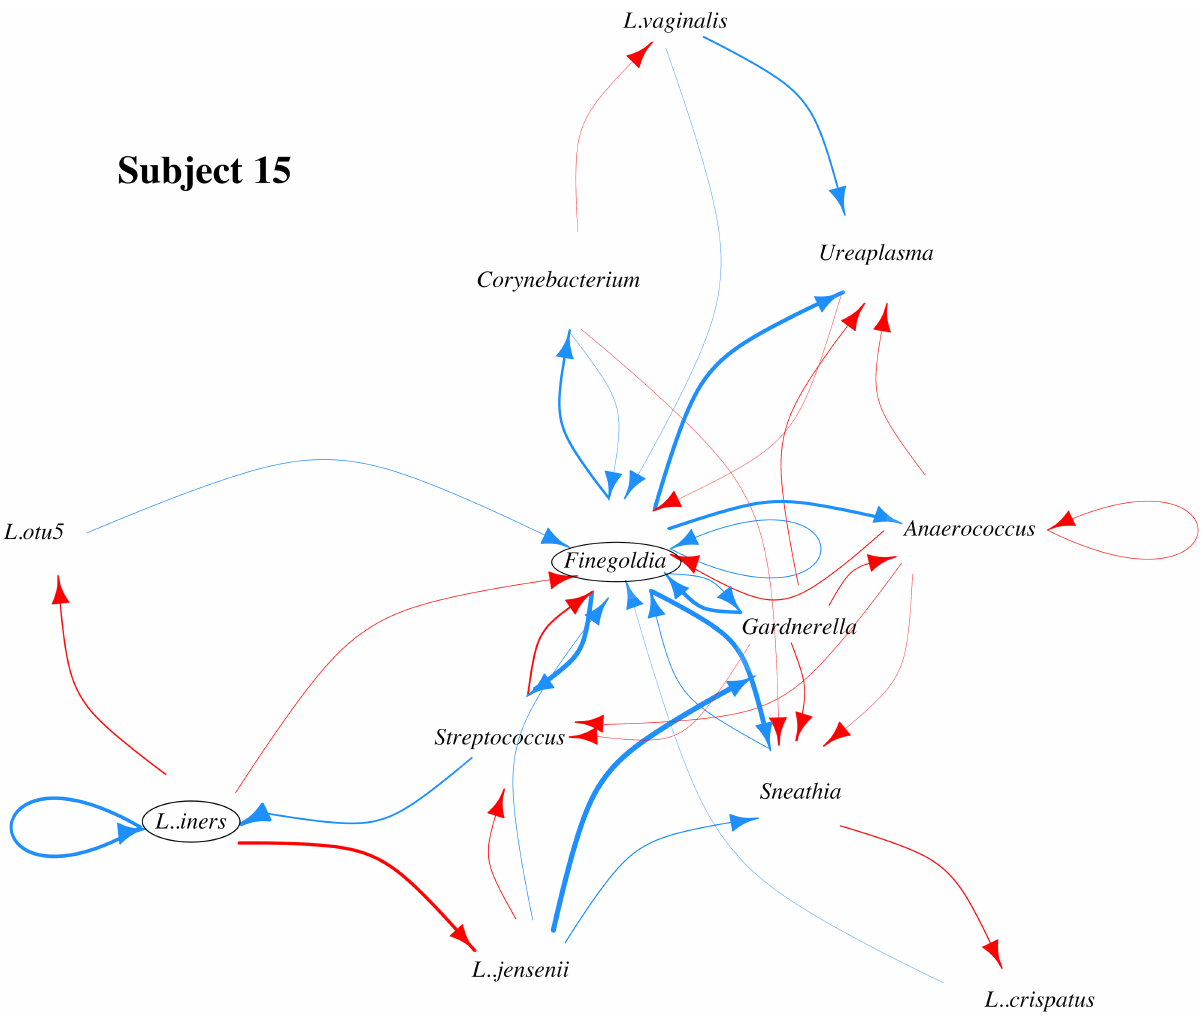
Fig 3. Microbial interaction network (MIN) for subject 15. Blue and red arrows indicatedirected positive and negativeeffects respectively.Arrow width indicateseffect magnitude. Circles highlightbacterialspecies that impact multiple other speciesin the MIN and whose critical role in the MIN has either experimental support in literature( L. iners ) or has never beenrecognizedbefore ( Finegoldia sp.